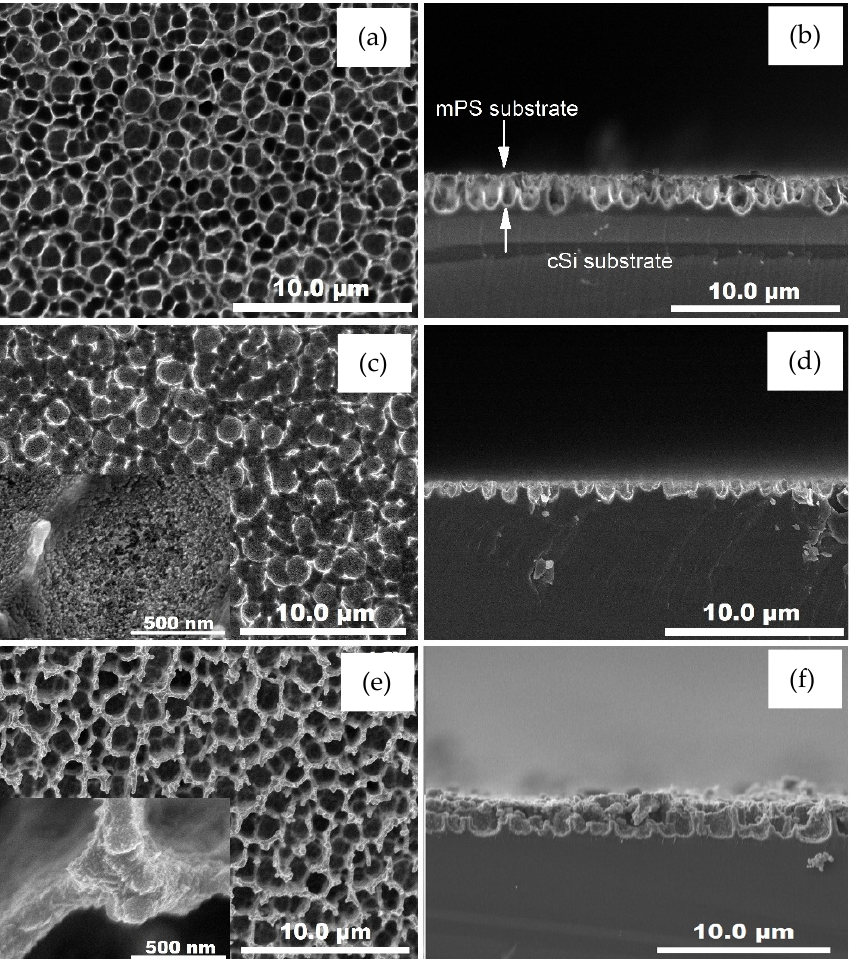
Figure 3. SEM micrographs of the top (left side) and cross (right side) sectional of bare mPS substrate ( a , b ); ZnO films deposited on mPS by sol–gel spin coating Z1P ( c , d ), and USP, Z2P ( e , f ) methods.